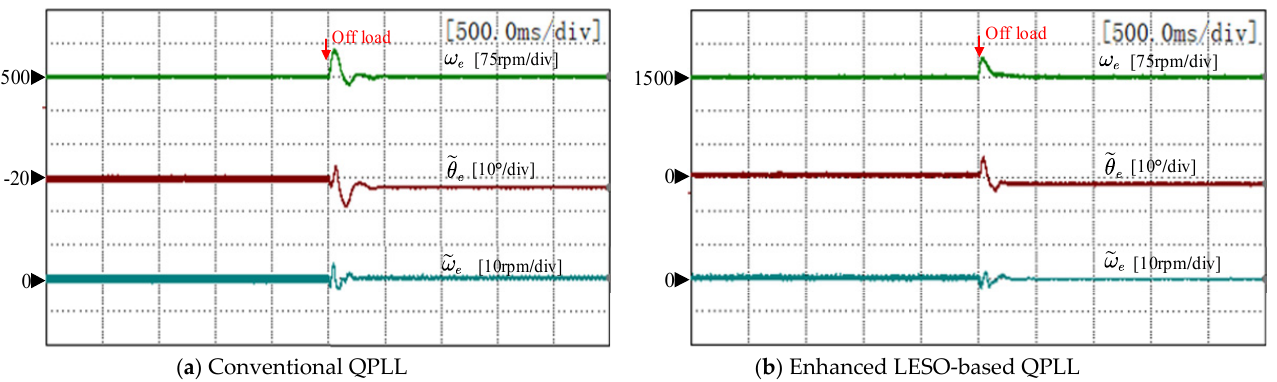
Figure 17. Experimental results of the real speed, the position estimation error, and the speed esti- mation error at 1500 rpm under load torque disturbance (5 N·m → 0 N·m).